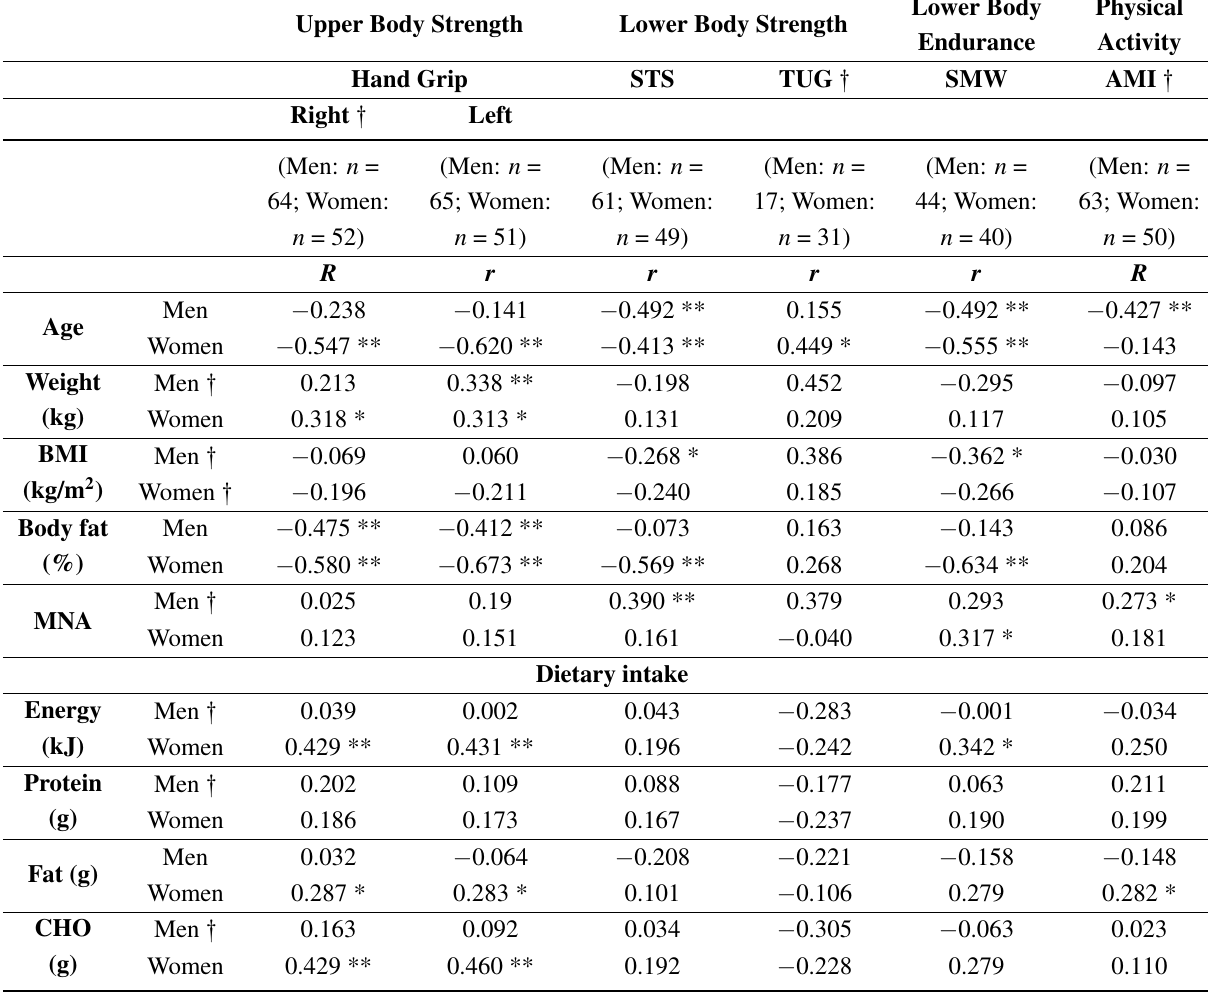
Table 2. Bivariate associations between body composition, nutritional status, strength and endurance (Pearson’s correlations, r